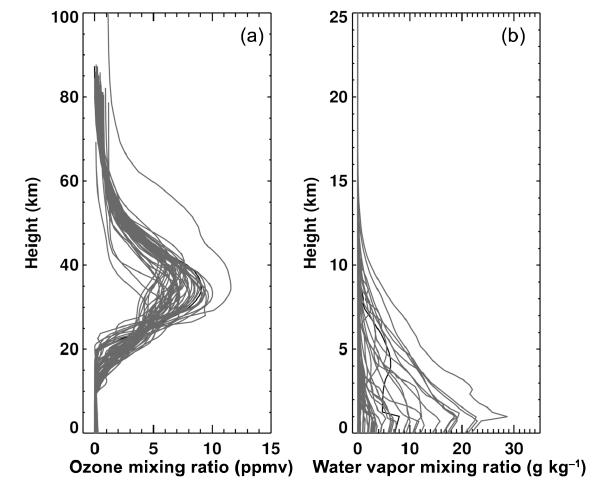
Figure 2. 52 different ECMWF profiles for (a) ozone and (b) water vapor used in the Line-By-Line Radiative Transfer Model to calcu- late the respective gas